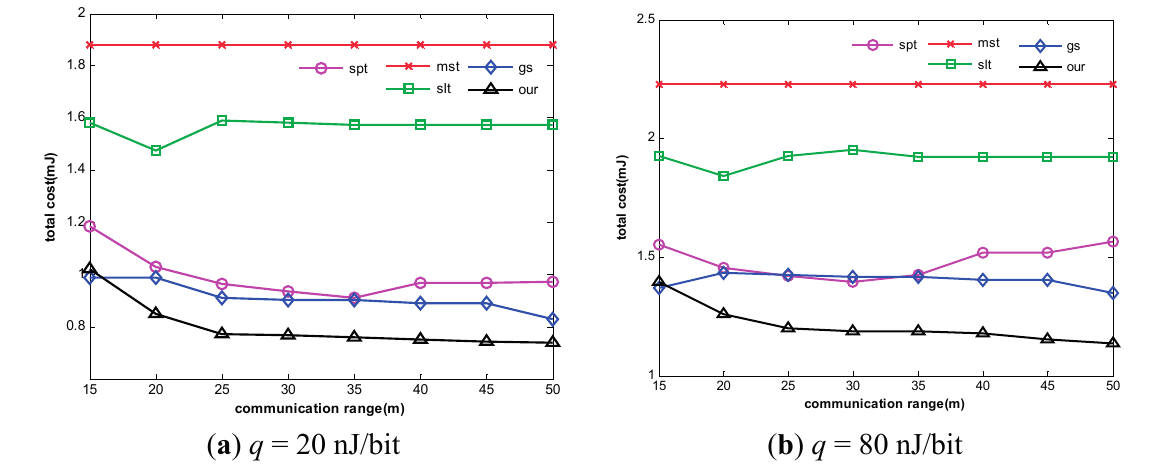
to energy consumption when k = c